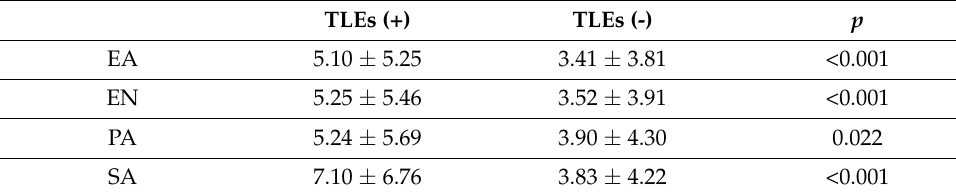
Table 2. The PQ-16 score with respect to a history of